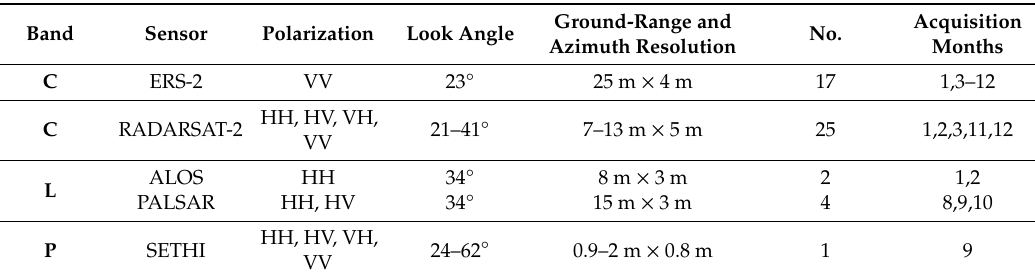
Table 1. Synthetic aperture radar (SAR) dataset for